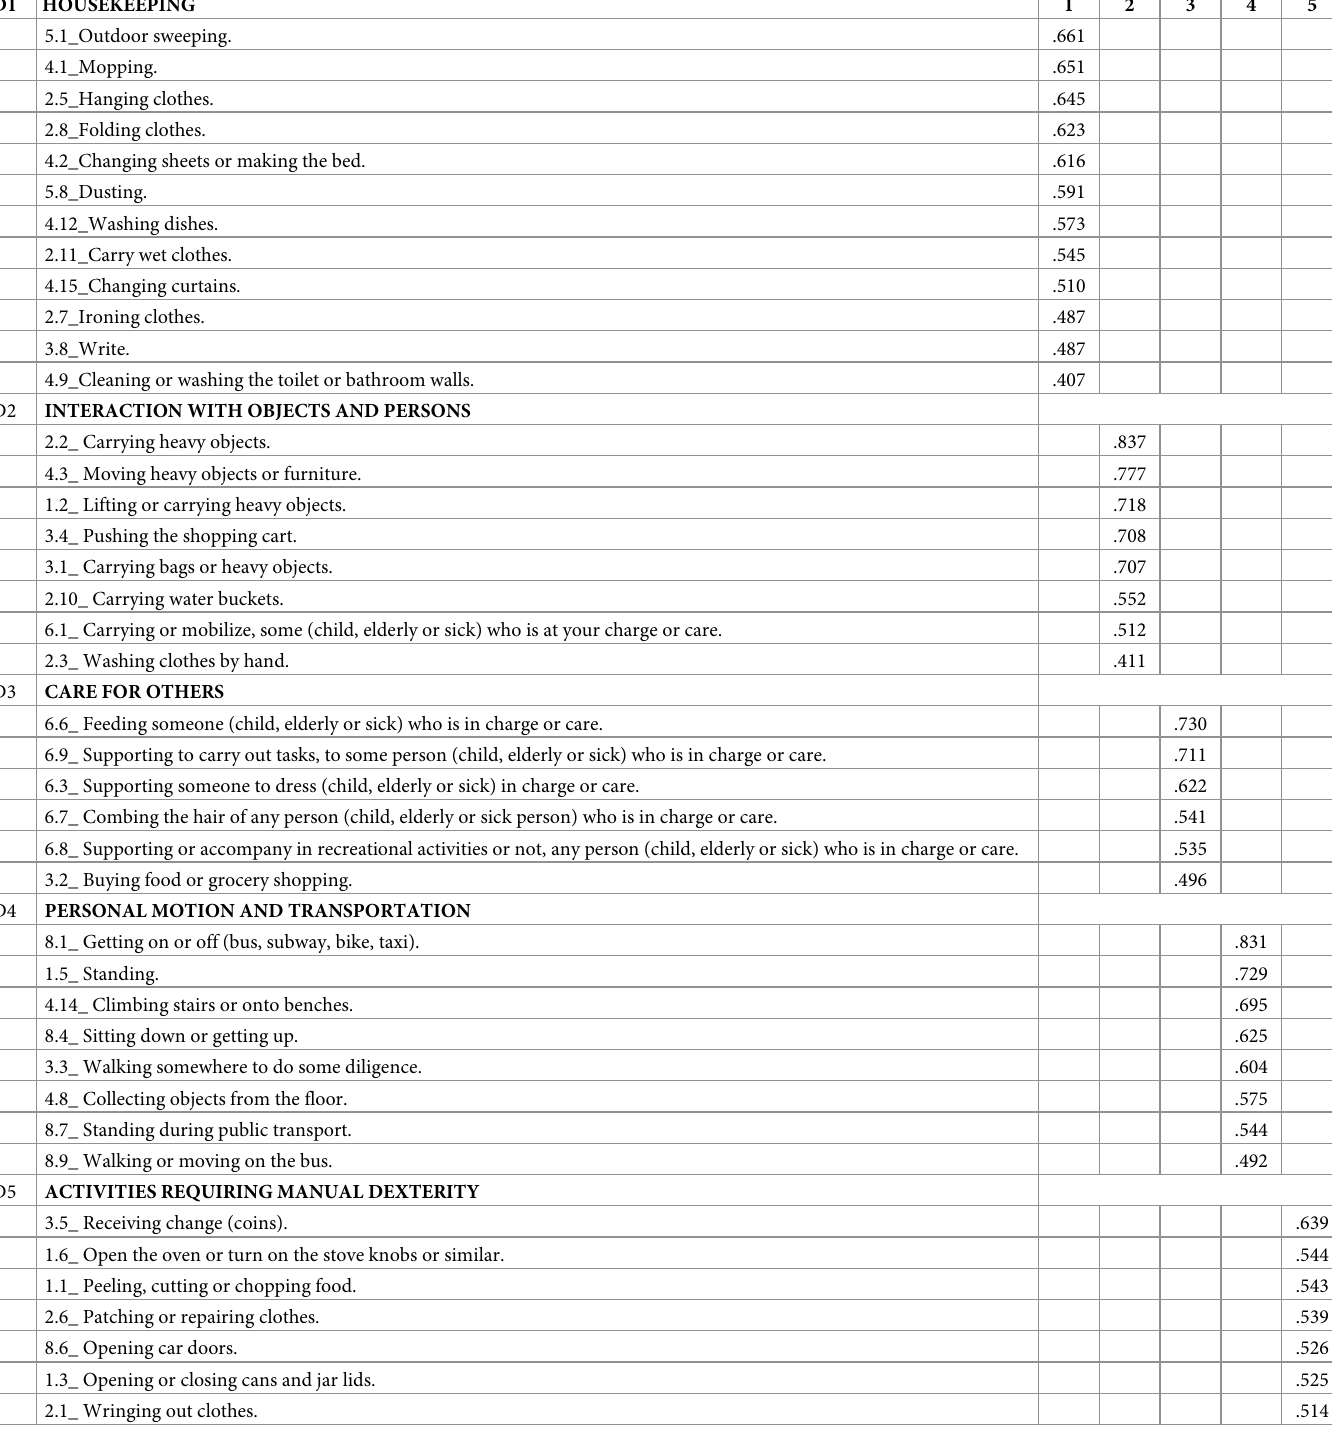
Table 5. Factor loadings for the 5 factors after direct oblimin rotation of the